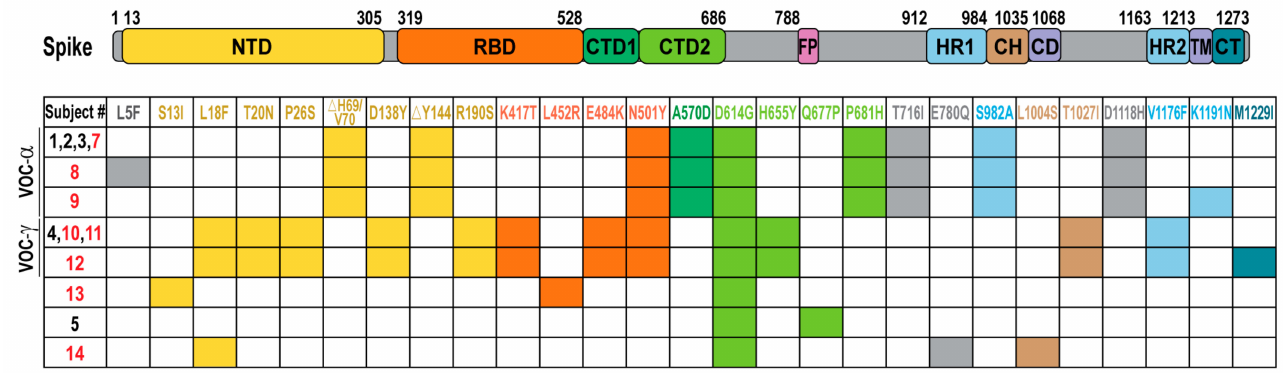
Figure 2. Multiple mutations in the SARS-CoV-2 spike gene were identified in subjects with breakthrough infections. Schematic diagram of the SARS-CoV-2 spike with functional domains highlighted in color. NTD: N-terminal domain; RBD: receptor-binding domain; CTD1 and CTD2: C-terminal domain 1 and 2; FP: fusion peptide; HR1: heptad repeat 1; CH: central helix; CD: connector domain; HR2: heptad repeat 2; TM: transmembrane domain; C t : cytoplasmic tail. The amino acid substitutions deduced from the nucleotide sequence detected in each subject are shown in the boxes and colored according to their location in the spike sequence. Subject numbers in red are the hospitalized